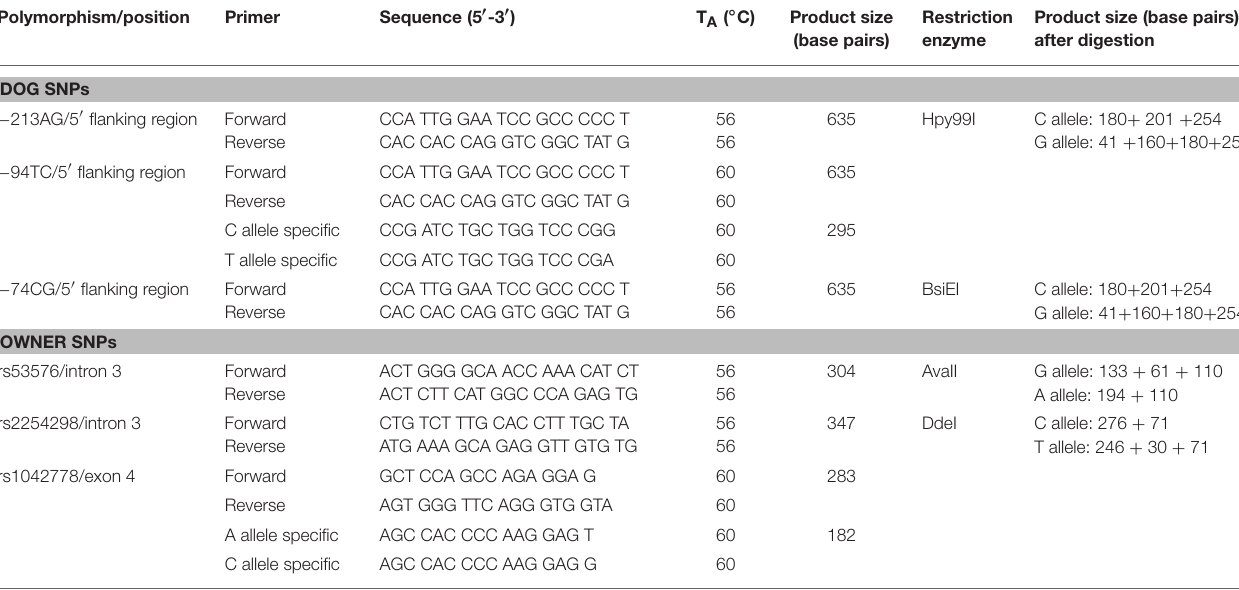
TABLE 2 | Summary of the SNPs included in the analysis. Polymorphism/position Primer Sequence (5 ′ -3 ′ ) Product size